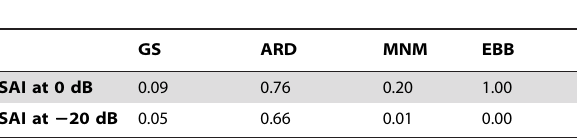
Table 1. SAI results for the four inversion schemes in the simulation trial presented in Fig.